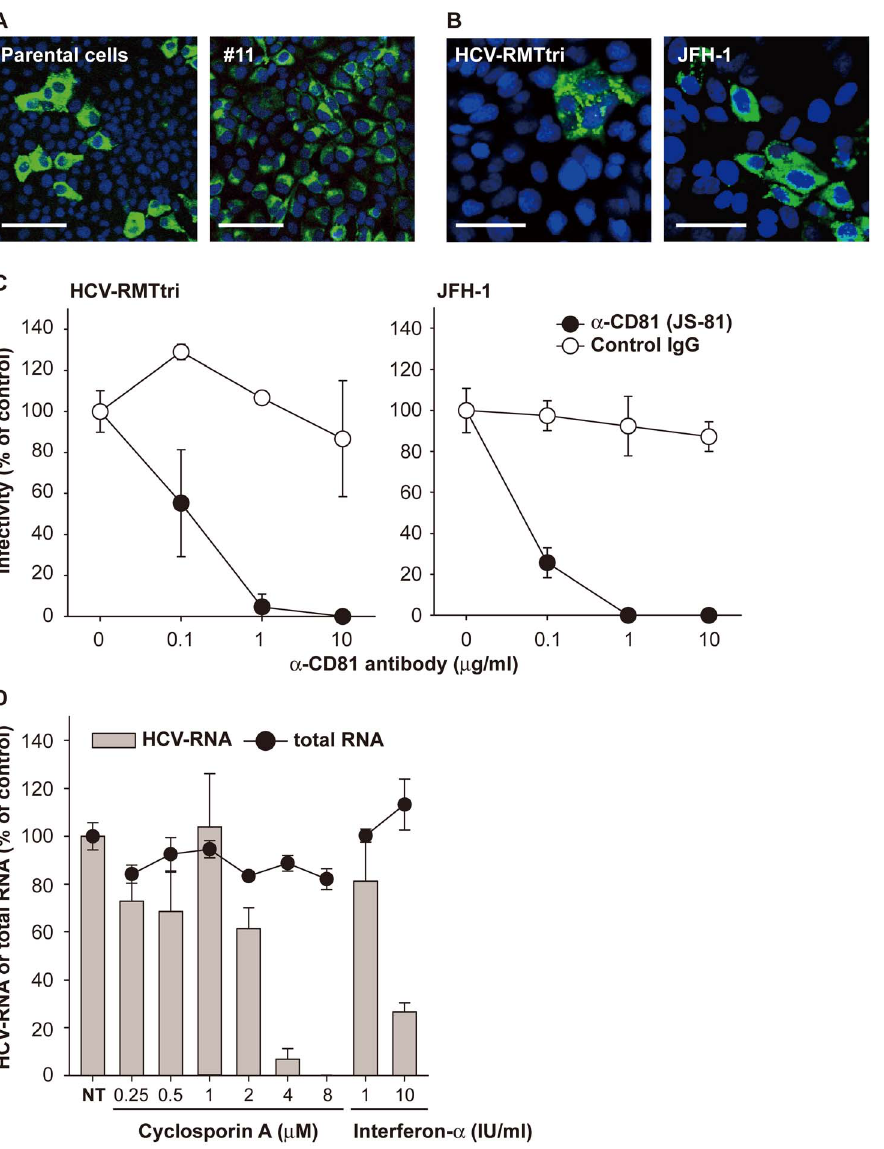
Figure 3. Establishment of HCV-RMTtri highly replicating # 11 cell and infectivity of its supernatant on naı¨ve HuH7-K4 cells. (A) Immunostaining for the HCV core protein in HCV-RMTtri-electroporated parental cells and the cell clone ( # 11) obtained by limiting dilution cloning. Scale bar = 100 m m. (B) Immunostaining for the HCV core protein in naı¨ve HuH7-K4 cells infected with supernatants of HCV-RMTtri- or JFH-1- replicating cells. Scale bar = 50 m m. (C) Infection with the HCV-RMTtri supernatant was inhibited with anti-CD81 antibody in a similar manner as JFH- 1. Control IgG (normal mouse IgG 1 ): open circles, anti-CD81 mAb (JS-81): closed circles. Data are indicated as the mean 6 S.D. (D) Replication of HCV- RMTtri in HuH7-K4 cells was inhibited by HCV replication inhibitors such as cyclosporin A and interferon- a . Drugs were added to # 11 cells in 96-well plates 1 day after passaging, and cells were harvested after 72 h of treatment. NT: no treatment.